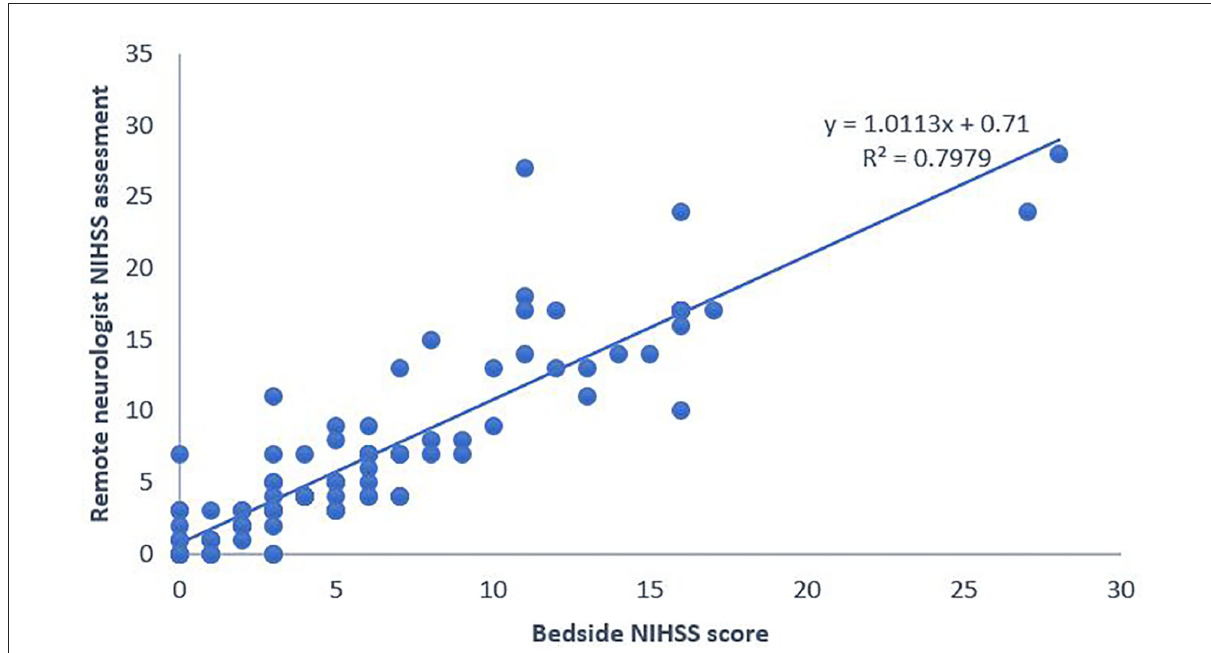
FIGURE2 National Institute of Health Stroke Scale (NIHSS) scores set using the system remotely compared with those set at bedside. NIHSS, National Institute of Health Stroke Scale.